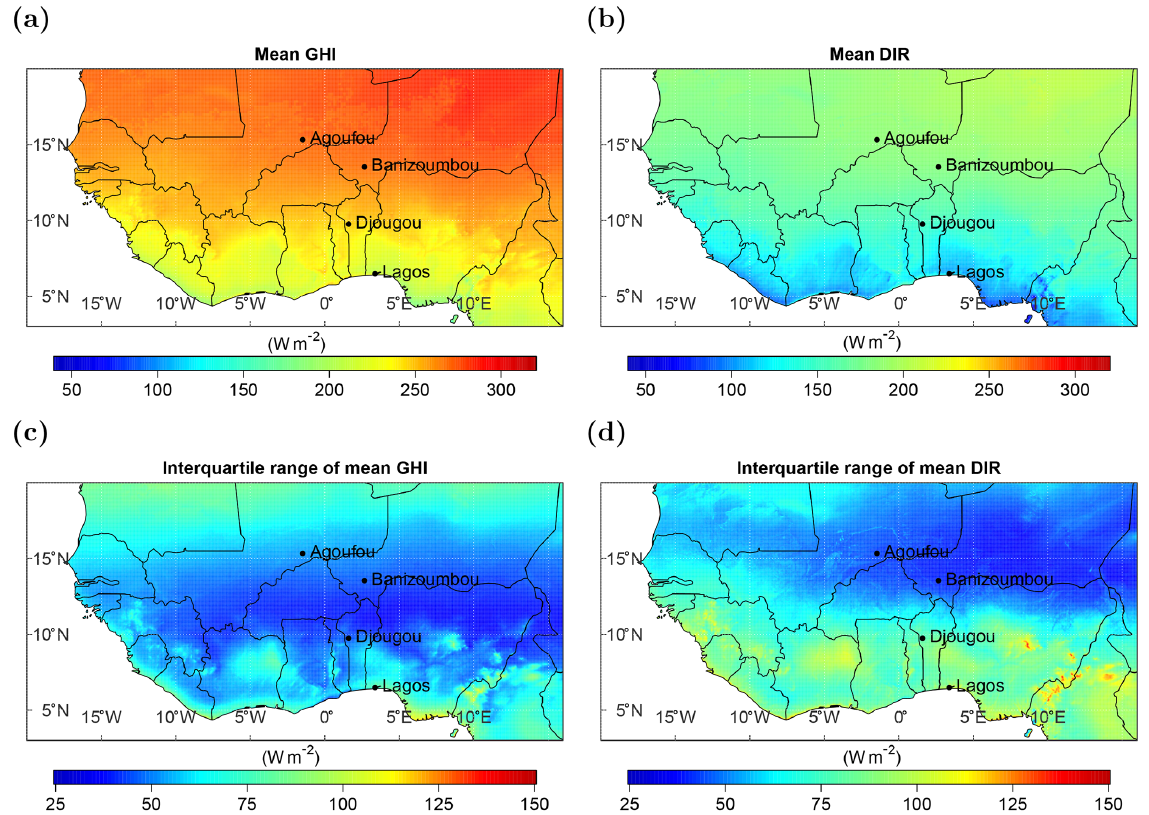
Figure 5. Mean (1983–2017) global horizontal irradiance (a) and direct horizontal irradiance (b) with their respective temporal interquartile ranges given in panels (c) and (d) .